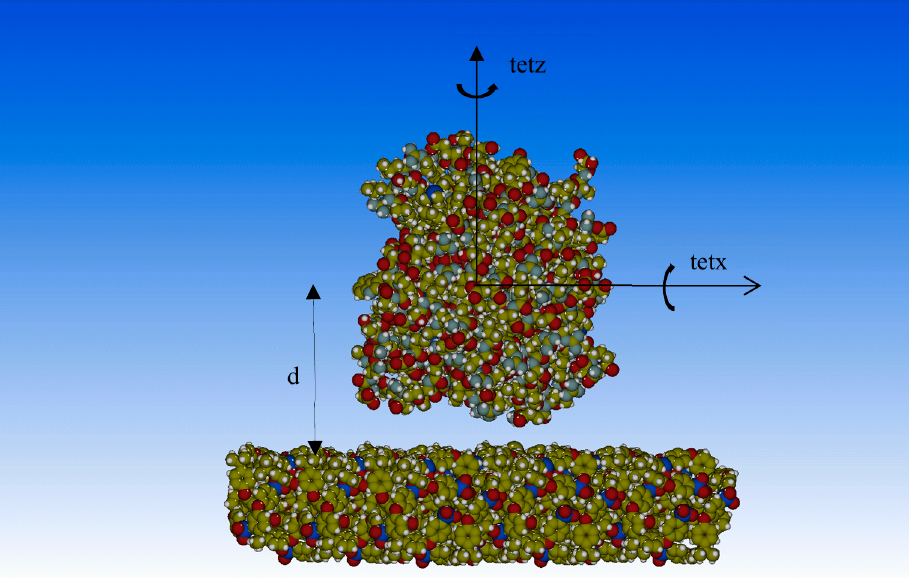
Figure 1. Phosphotriesterase (PTE) on polysulfone surface, d = protein–surface distance, tetz and tetx protein rotations around the Z and X axis, respectively, used for the calculation of the interaction energy.